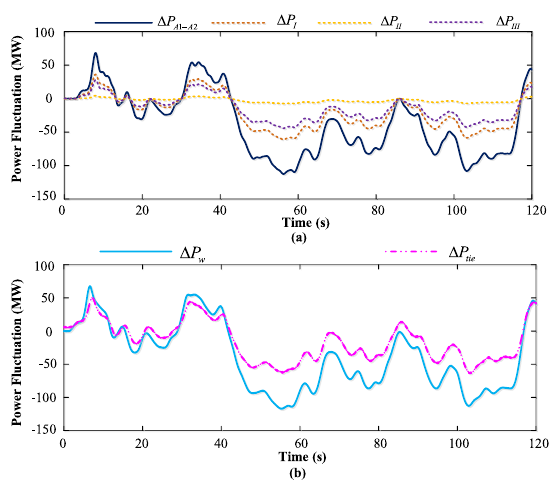
Fig. 13 Simulation results in Scenario B1 . a The active power fluctuations on transmission lines between Area 1 and Area 2, b the wind power fluctuation and the power fluctuation on the tie-line